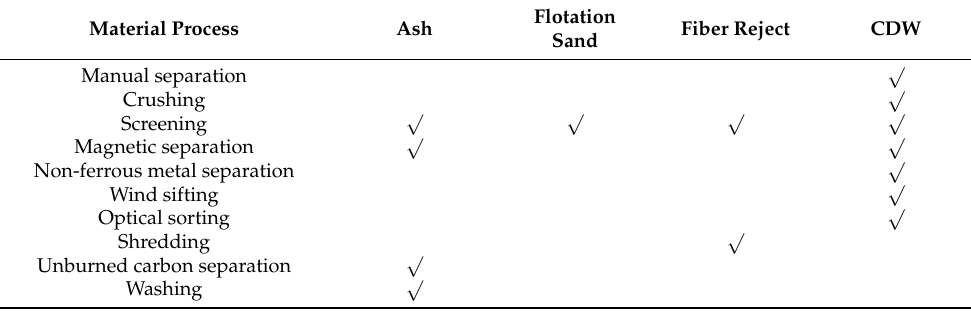
Table 4. Pretreatment processes needed for each industrial waste in combined line treatment.